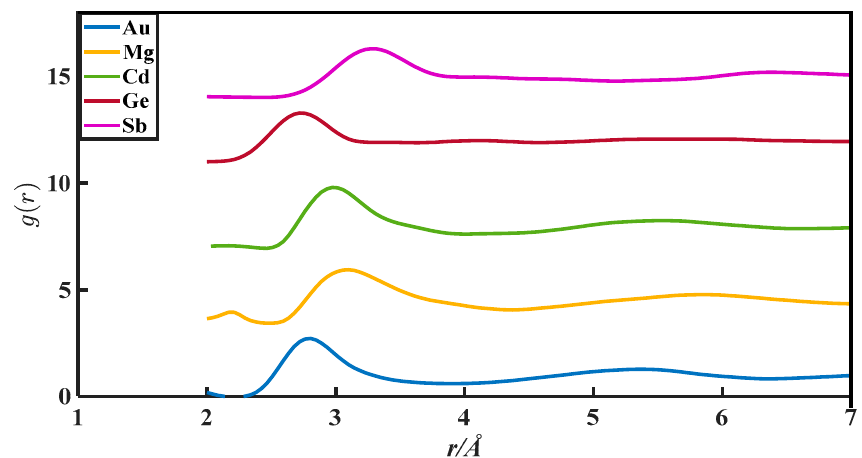
Figure 1. The pair distribution function of Au, Mg, Cd, Ge, and Sb.